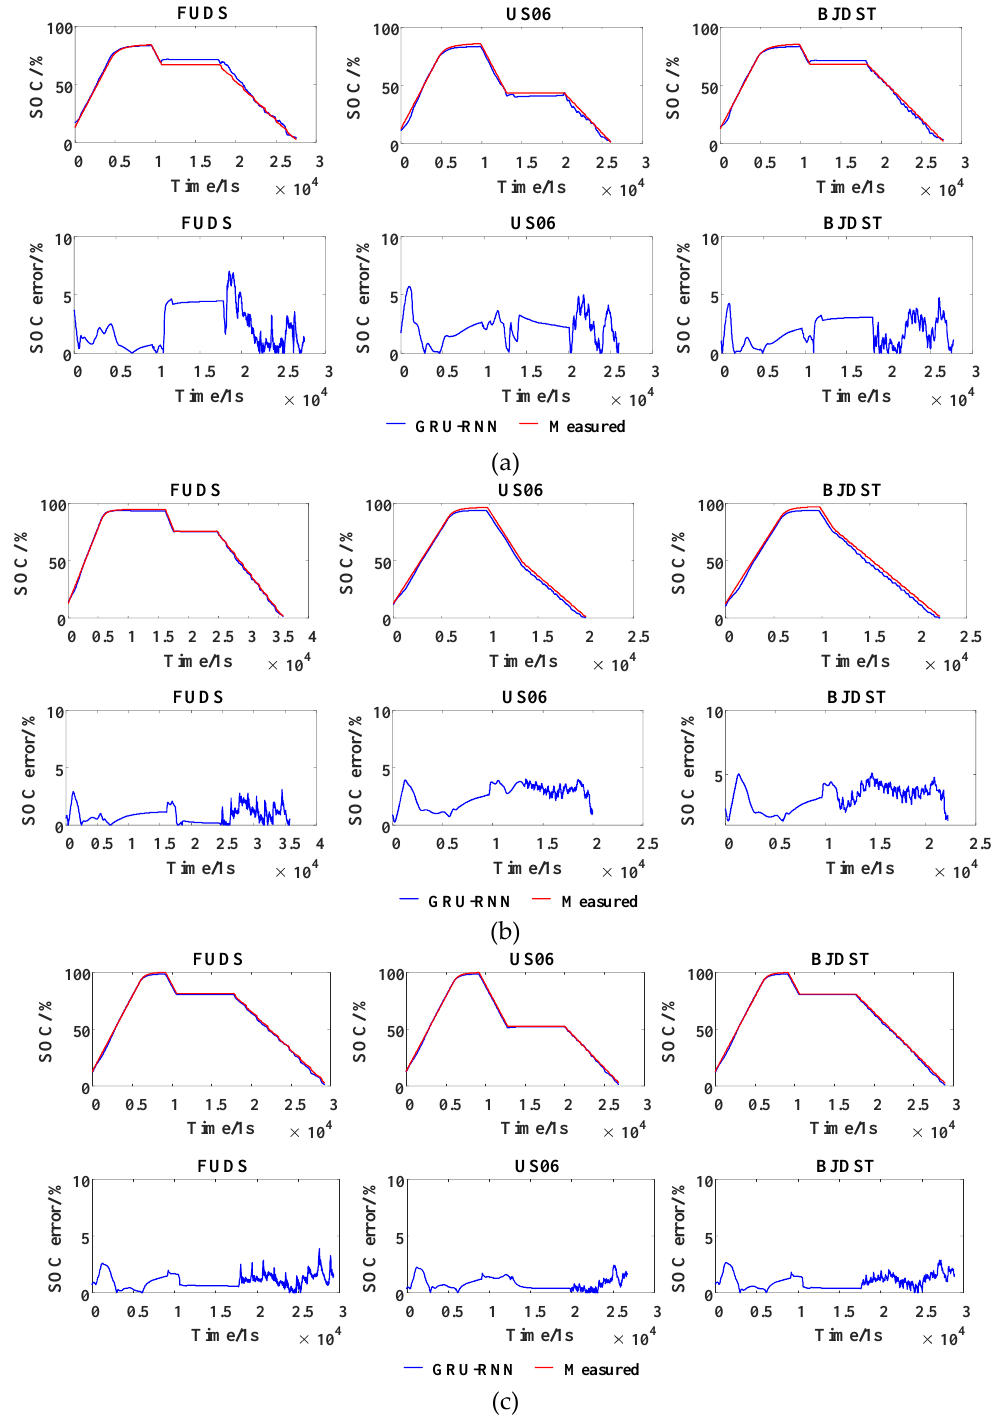
Figure 15. SOC estimation curves under mixed charge-discharge conditions: ( a ) 0 °C; ( b ) 25 °C; ( c ) 45 °C. Table 5. SOC estimation results under mixed charge-discharge conditions.